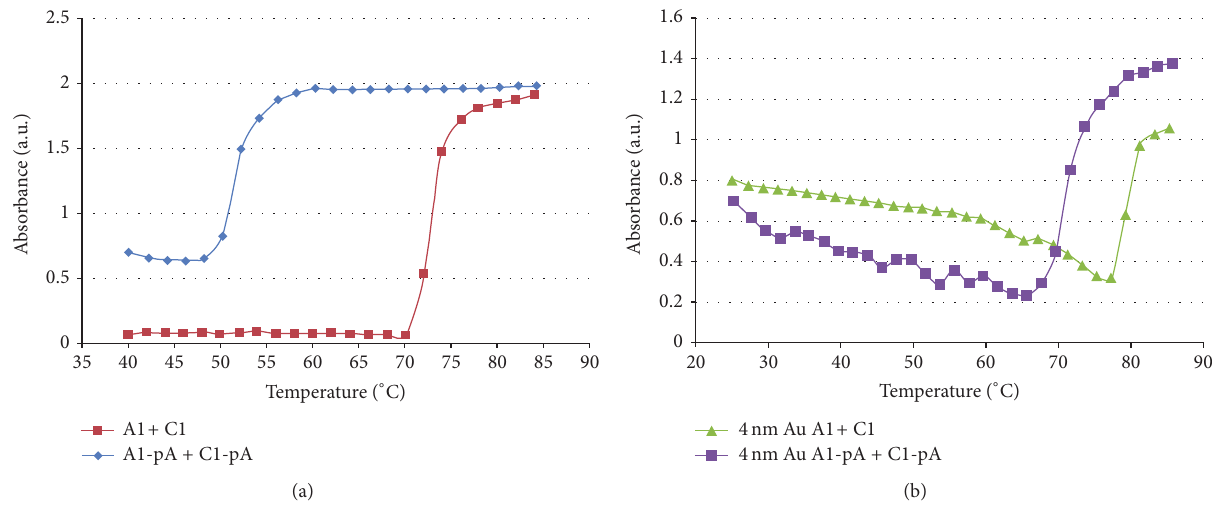
Figure2:Dehybridizationcurvesforhybridized13 nmand4nmAuNPs.(a)Hybridized13 nmAuNPsin100mMNaClbuffer.(b)Hybridized